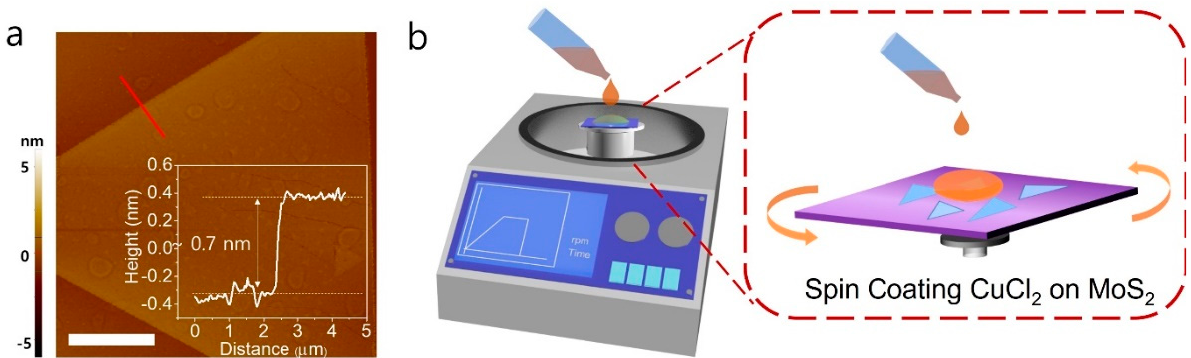
Figure 1. CuCl 2 doping process for MoS 2 monolayers. ( a ) AFM topography image of MoS 2 monolayers showing its atomic thickness around 0.7 nm. Scale bar: 5 μ m. ( b ) Schematic illustration of CuCl 2 doping process. The as-synthesized MoS 2 monolayers on SiO 2 /Si substrate were placed on a spin coater, and CuCl 2 solution was dropped onto the substrate for spin coating at 3000 RPM.